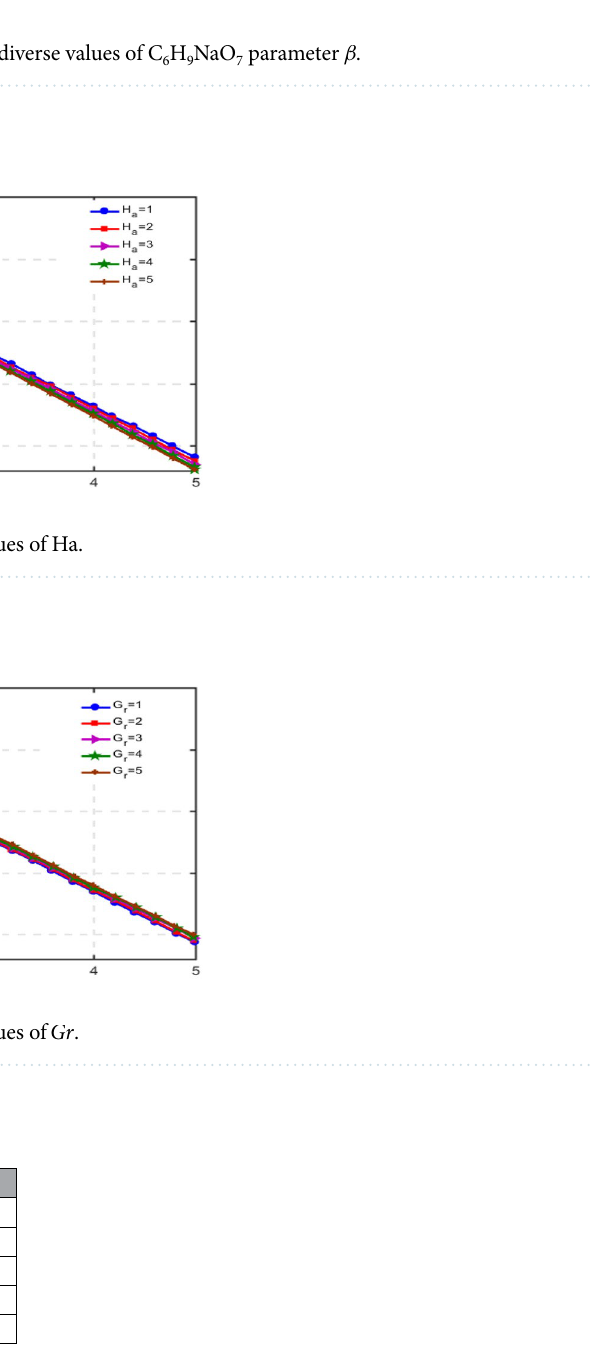
Table 2. Finite difference scheme results of velocity for different values of β